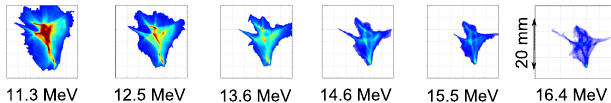
FIG. 6. Proton imprint (in units of deposited energy) in the RCF layers for energies larger than the focused one with corre- sponding Bragg energies. Contrary to the expectations, a focused feature is still detectable up to the last layer.